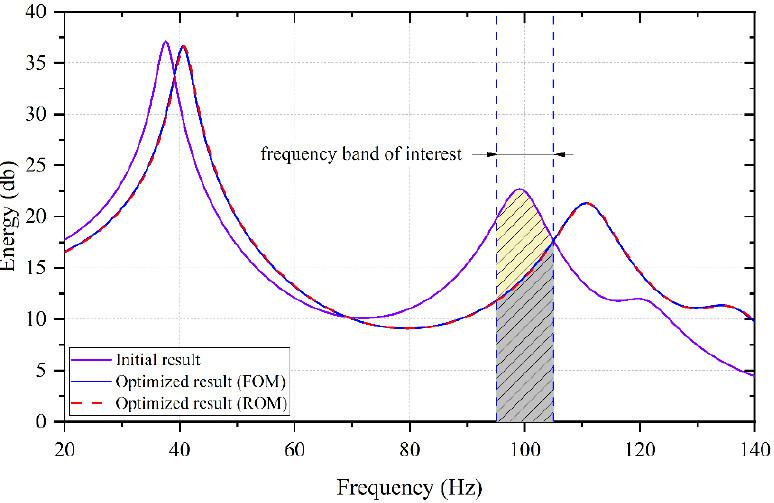
Figure 20. Energy frequency response of the PAF structure before and after optimization. Table 3. Vibration reduction optimization results of PAF.